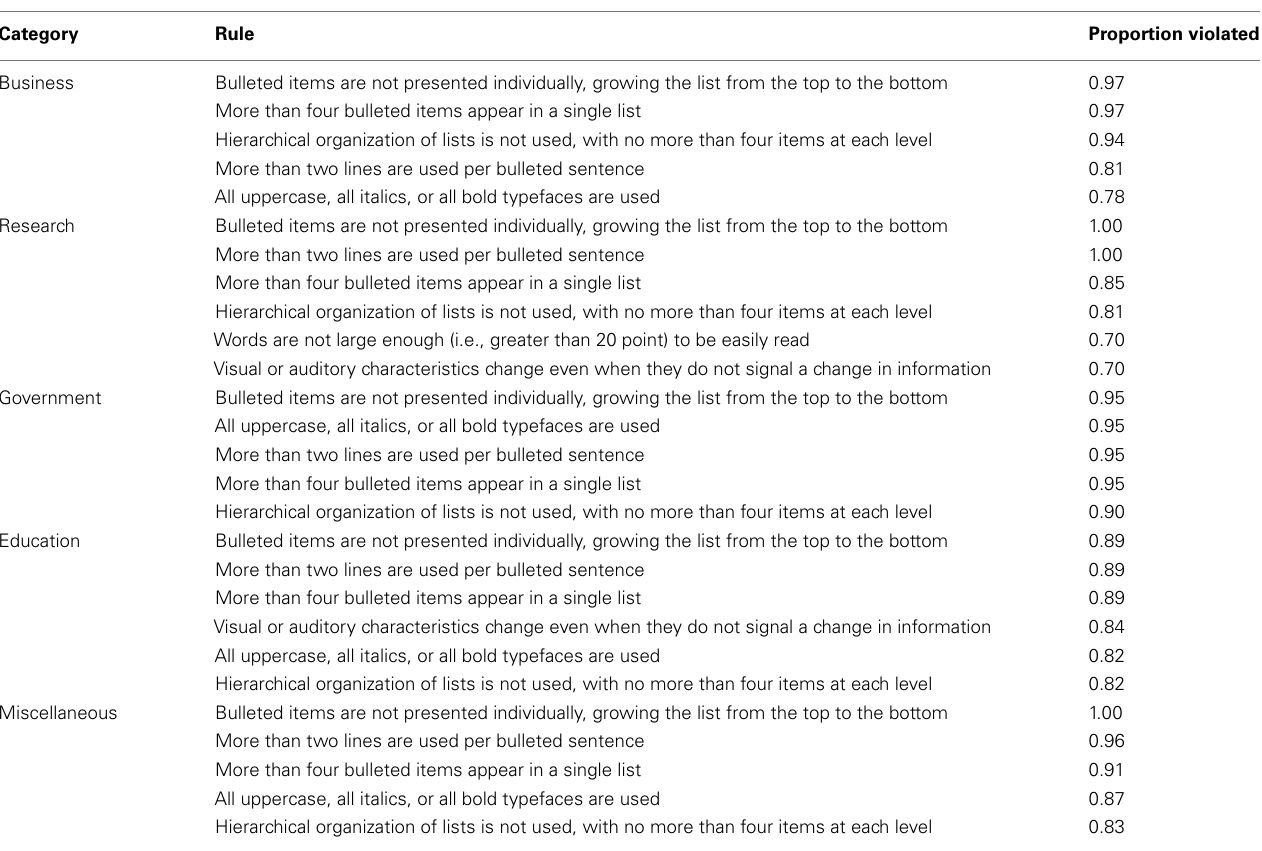
Table 3 | Most frequently violated rules per category (strict scoring) for Study